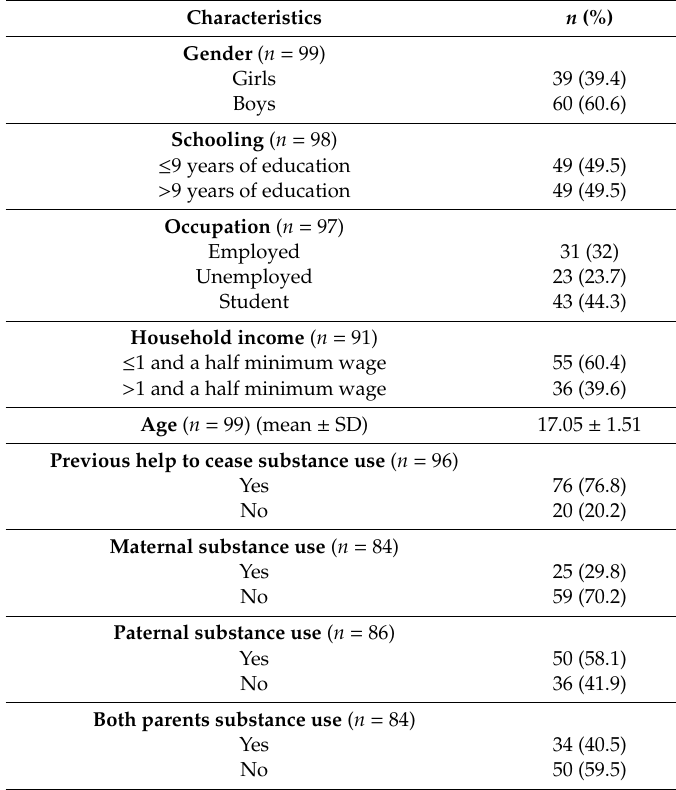
Table 1. Sociodemographic characteristics of the adolescents ( n =